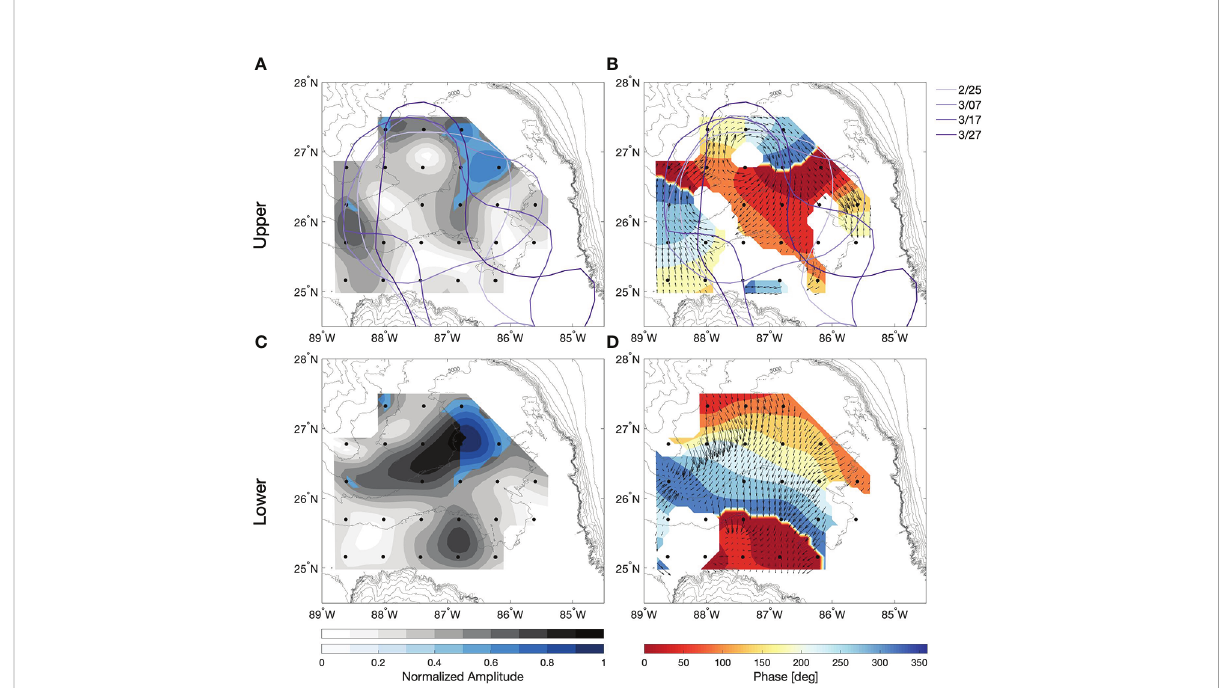
FIGURE 9 Coupled CEOF from 1/20 – 1/10 day – 1 band-passed baroclinic sea surface height, SSH bcb (upper) and reference sea surface height, SSH ref (lower) during LCE Ursa detachment. Normalized spatial amplitude is on the left panels (A, C) and phase in degrees is on the right (B, D) . Normalized amplitude is plotted in color only where both the upper and lower exceed 0.4. Phase is plotted only in regions where the spatial amplitude is greater than 0.3. The position of the LC, determined from SSH satellite altimetry, is contoured every 10 days during Ursa detachment on the upper panels. Bathymetry is contoured in gray every 250